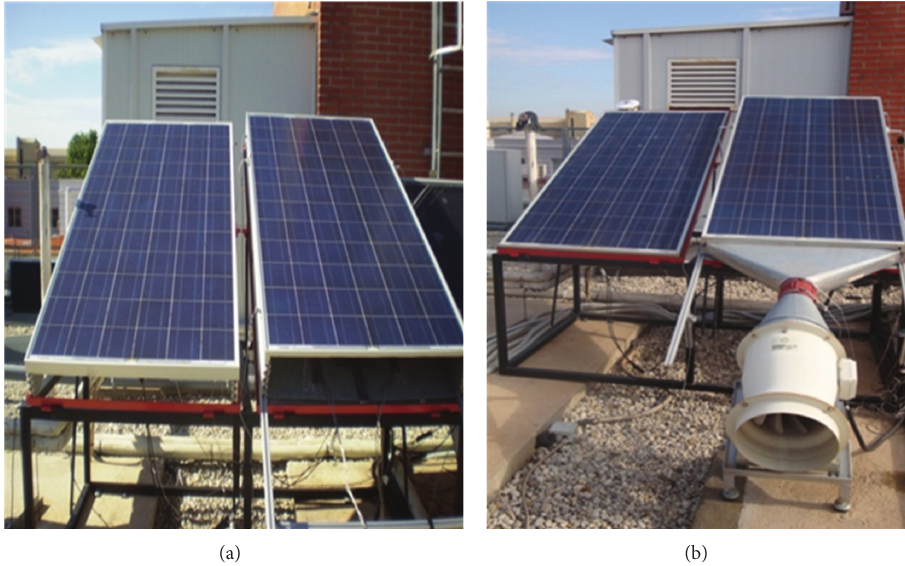
Figure 1: Solar experimental facility. Left panel labelled as panel A is not modified and the right panel labelled as panel B is above a steel plate, creating an air channel underneath it. (a) Natural convection configuration. (b) Forced convection